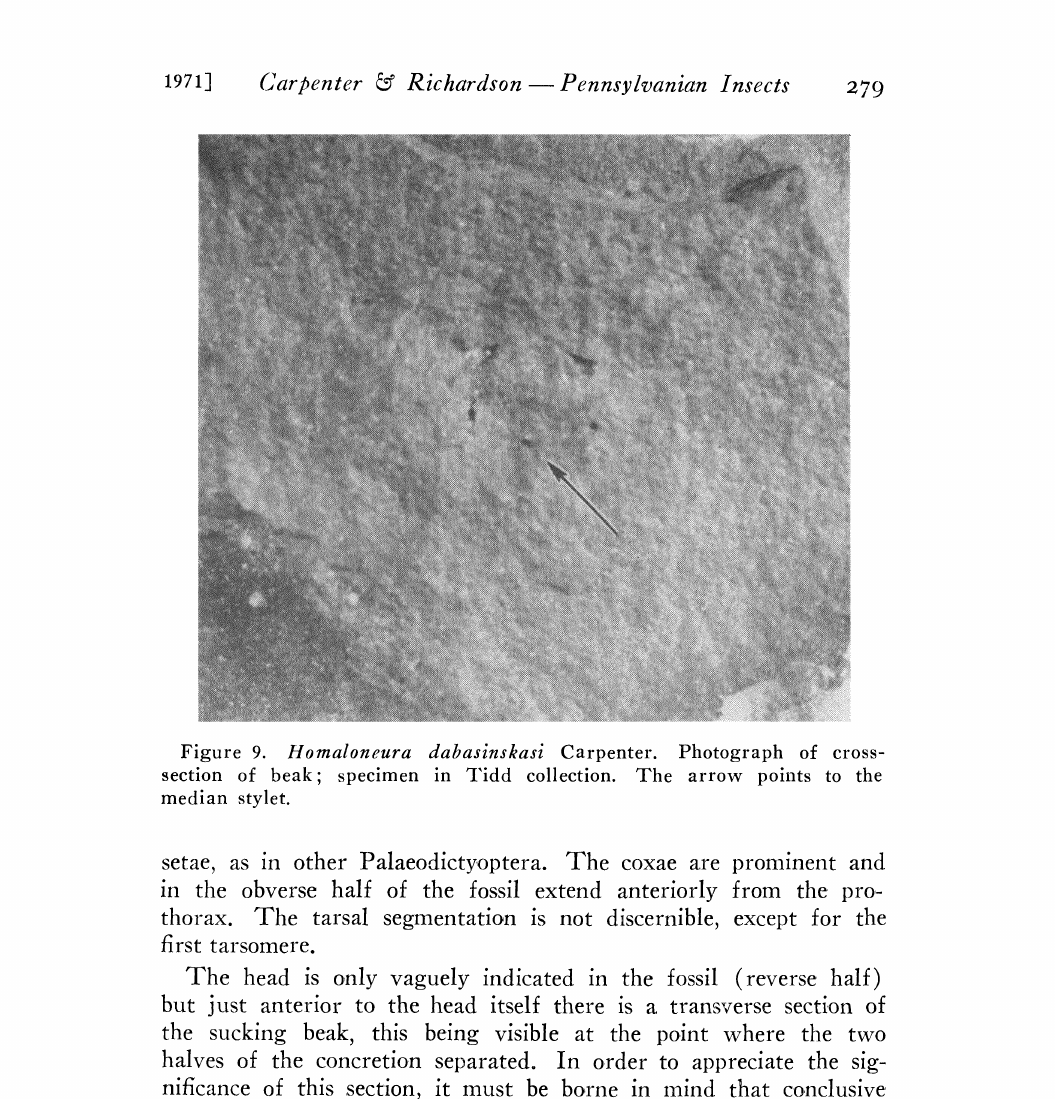
Figure 9. Homaloneura dabasinskasi Carpenter. Photograph of cross- section of beak; specimen in Tidd collection. The arrow points to the median